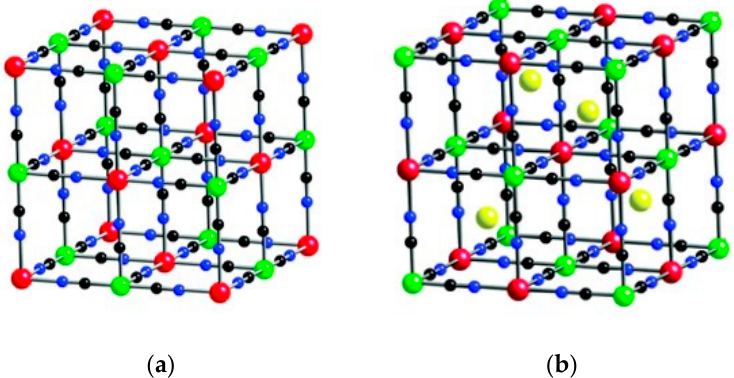
— Figure 3. ( a ) The unit cell structure of PB in the possible Fm3m space group. The Fe III , Fe II , C, and N are represented by the red, green, black, and blue spheres, respectively. ( b ) An example crystal structure diagram of A x M a [M b (CN) 6 ]. In this case, the A-sites metals are shown by the yellow balls. The M a is demonstrated in red while M b is in green, and the C (black) and N (blue) act as the bridge between them. The water molecules are not shown here due to the complexity of their orientation. Adapted with permission from [46]. Copyright © 2016, Royal Society of Chemistry.